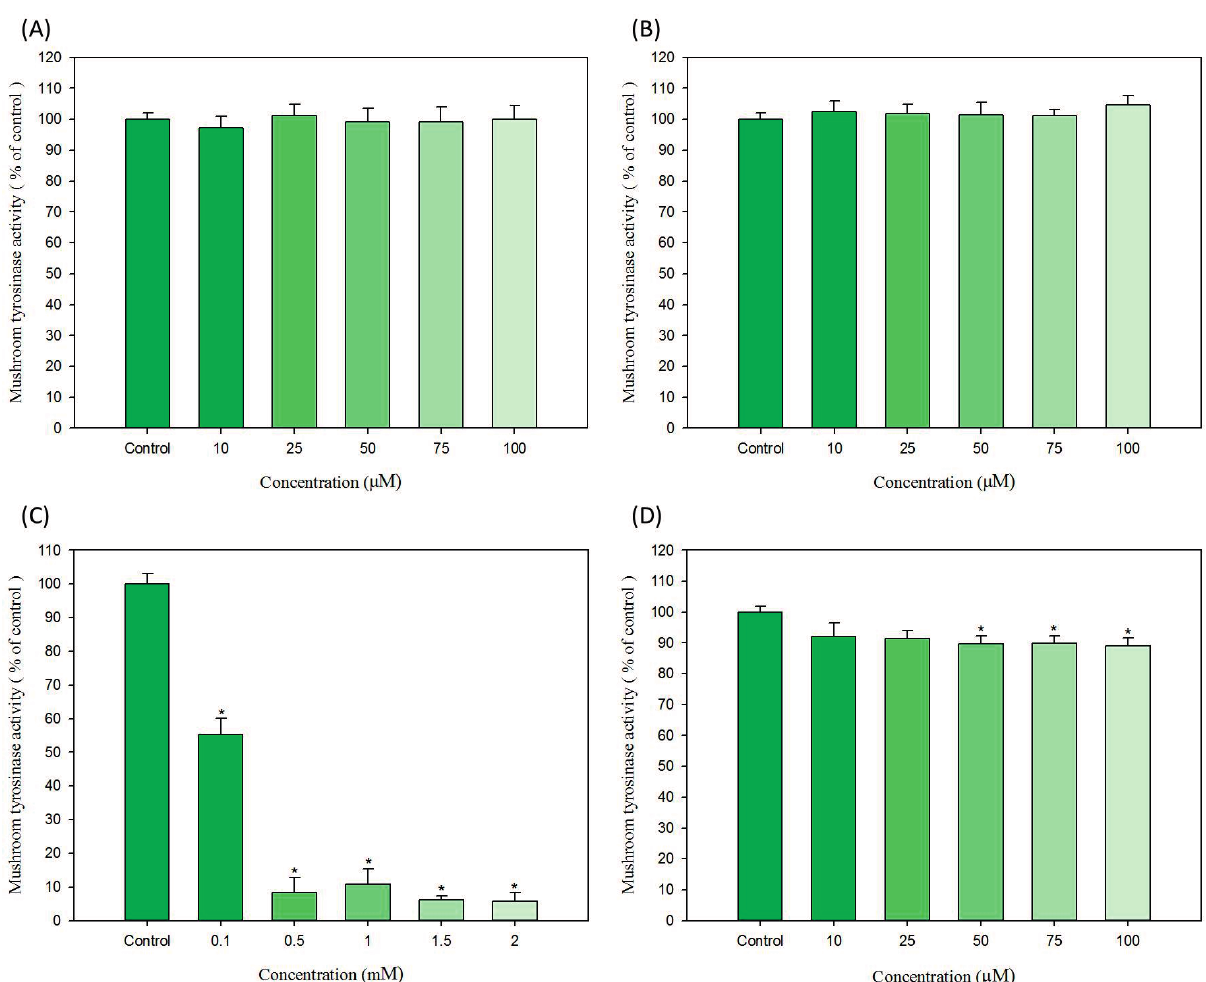
Figure 4. In vitro effects of hair dyes on the activity of mushroom tyrosinase. ( A ) ammonium persulfate; ( B ) sodium persulfate; ( C ) resorcinol and ( D ) lawsone. Each value is expressed as the mean ± S.E. ( n = 6). * p < 0.05 compared with the